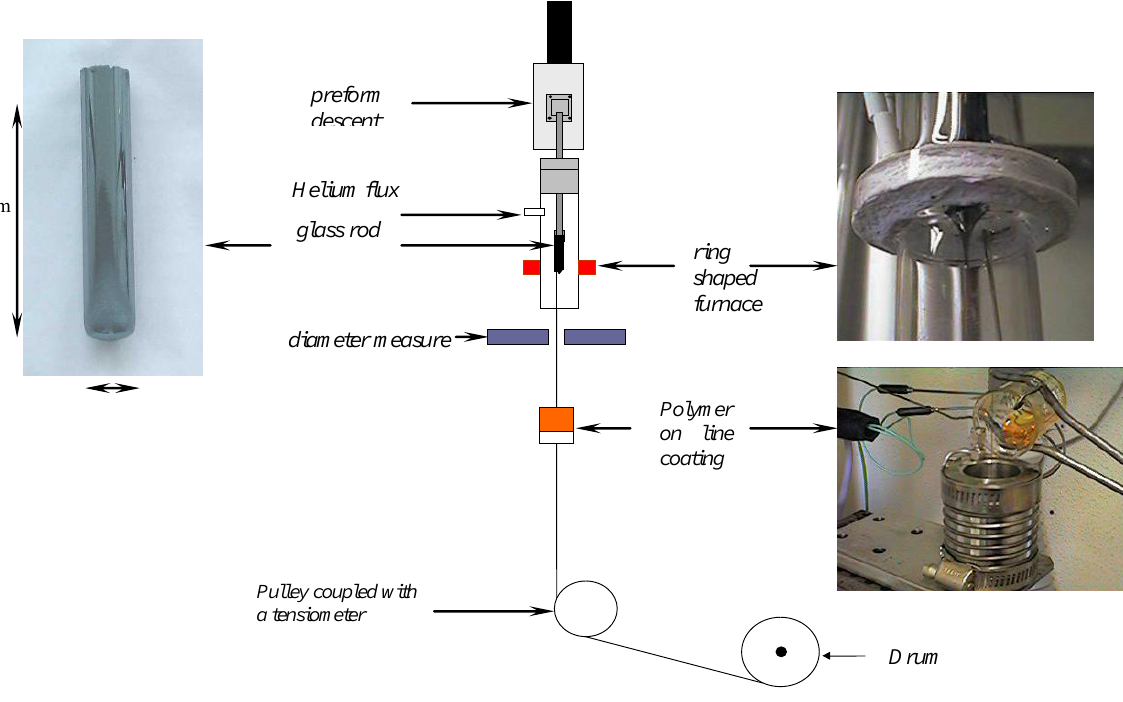
Figure 8. Schematic representation of the drawing tower. From a selenide glass rod photographed on the left, we obtain typically 25 m of fibre with a 400 µm diameter. Note that we can apply a coating polymer on-line to improve the mechanical behavior of the